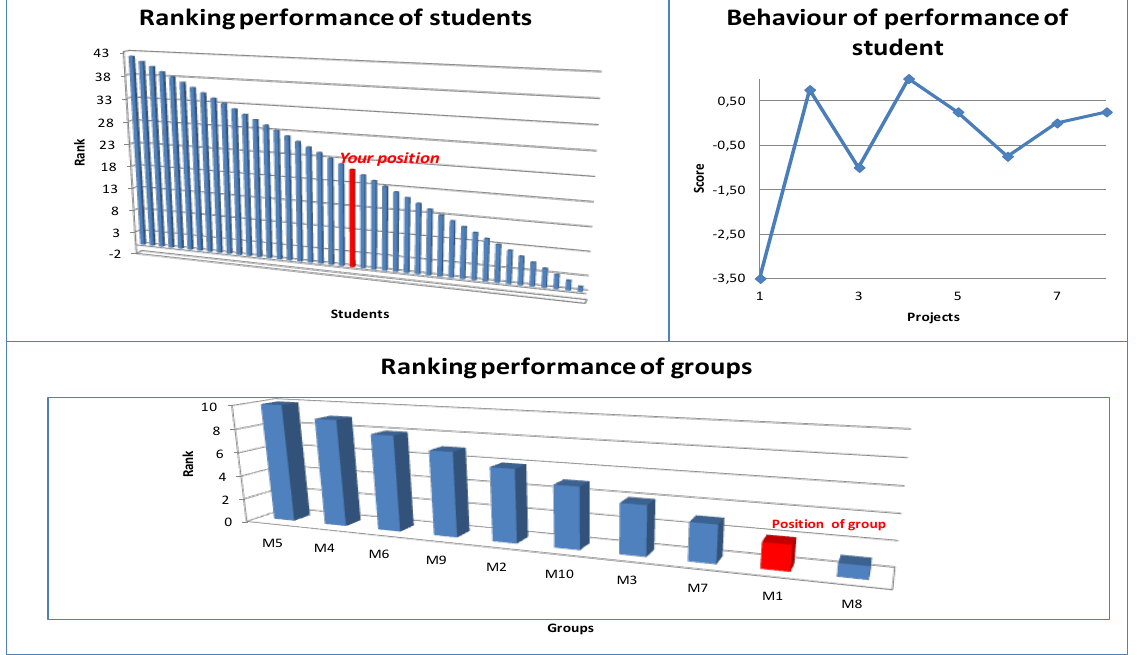
Figure 6 . Rankings of: individual position in relation to the class and group, the student behaviour along practices and position of group in relation to the